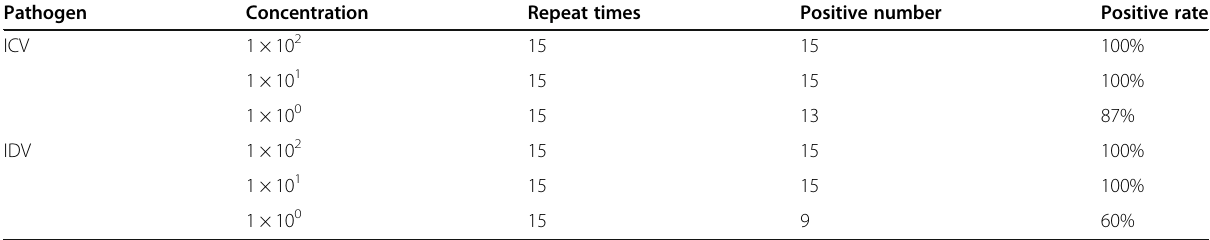
Table 2 Sensitivity test results of duplex real-time PCR assay